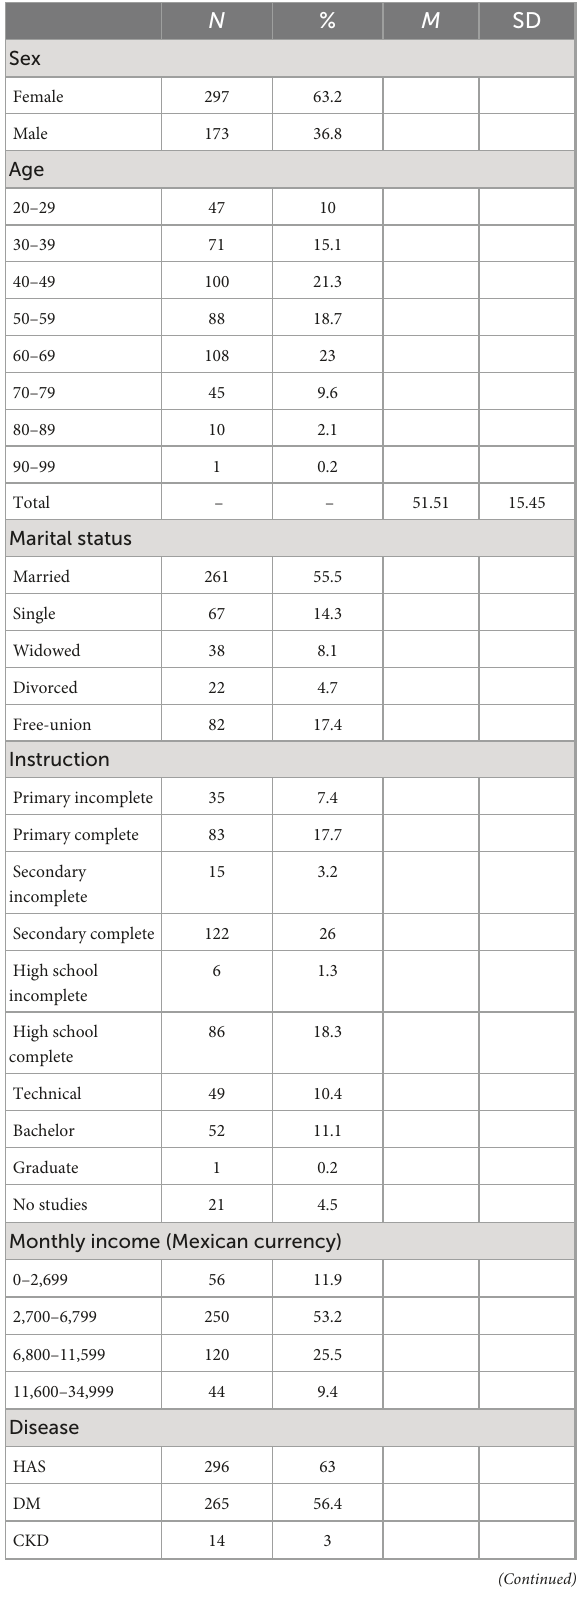
TABLE 2 Sociodemographic and clinical variables characteristics of patients with CDs ( n =